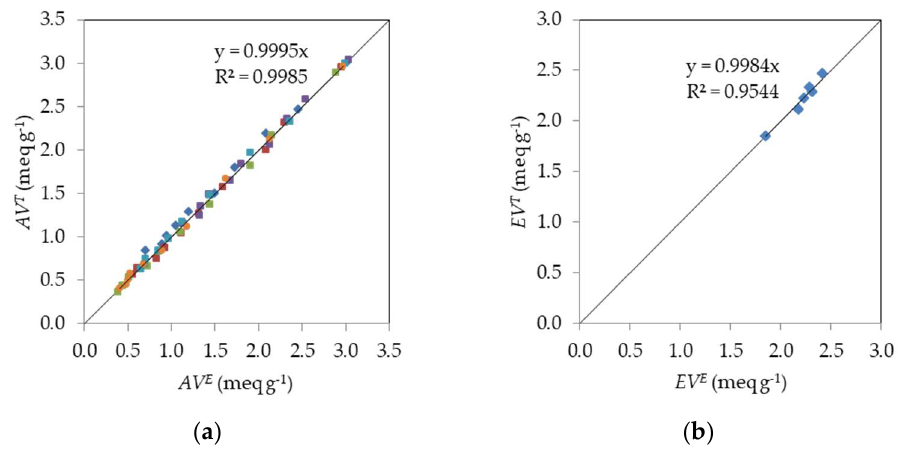
Figure 6. Fitting data of ( a ) the experimental acid number ( AV E ) and the predicted acid number ( AV T ) and ( b ) the experimental ester number ( EV E ) and the predicted ester number ( EV T ).